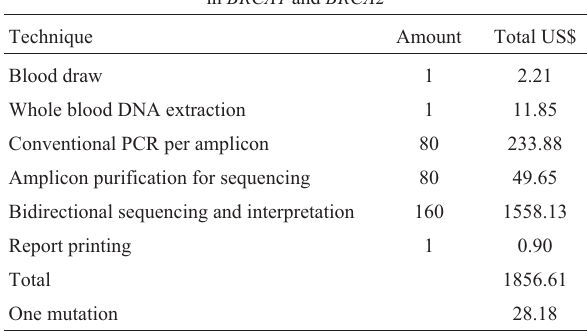
Table 3 - Cost calculation for the complete analysis of the coding se- quence of BRCA genes by Sanger sequencing using 100% of installed ca- pacity.